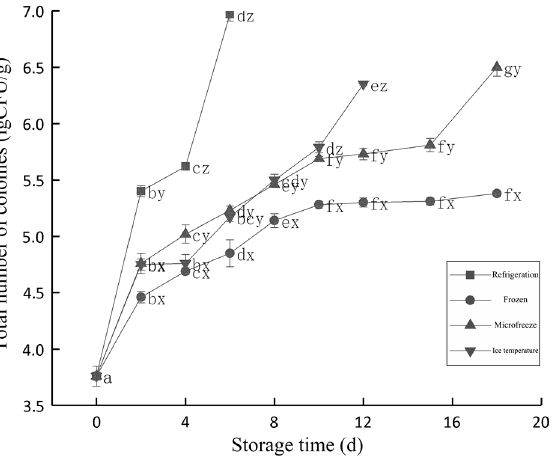
Figure 3. Changes in the total number of colonies in the beef storage with different low-temperature storage methods. d, day.